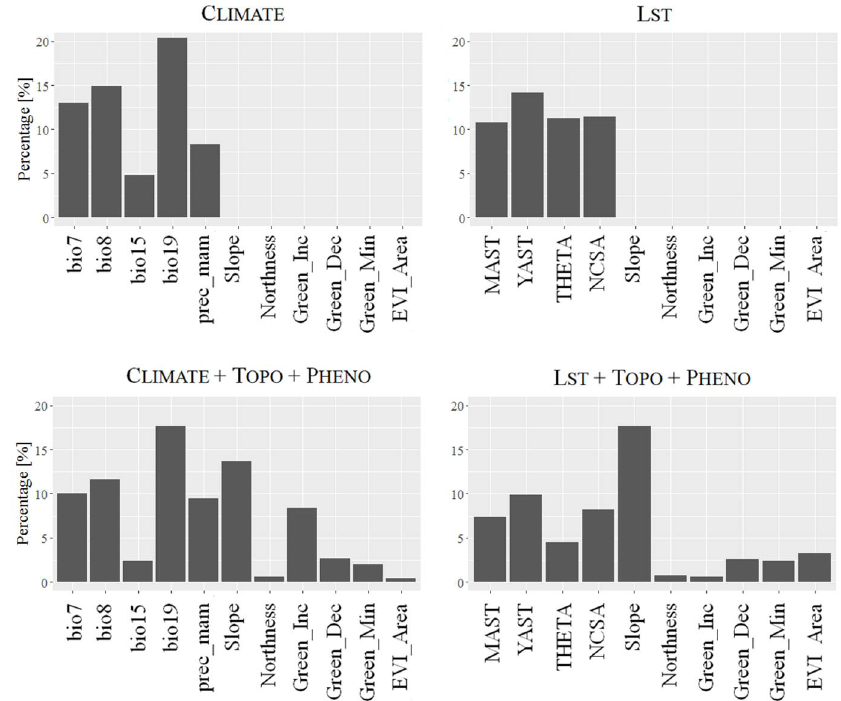
Figure 3. Variable importance of the models using four different predictor variable sets: Chelsa climate data and Land Cover Dynamics data (C LIMATE + P HENO ); Chelsa climate data (C LIMATE ); Land Surface Temperature and Land Cover Dynamics data (L ST + P HENO ); Land Cover Dynamics data (P HENO ) and Land Surface Temperature (L ST ) For variable description, see Table 1 and for variable importance of all models Supplementary Material Figure S1.